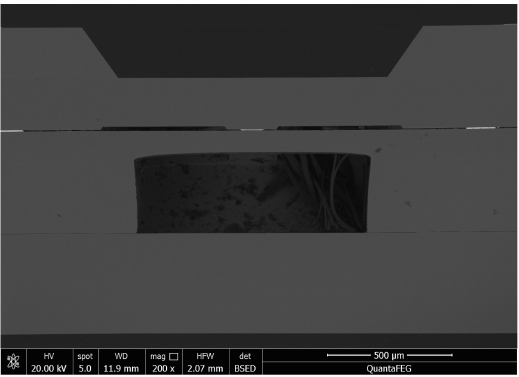
Figure 10. Dual bonding microscopic structure.